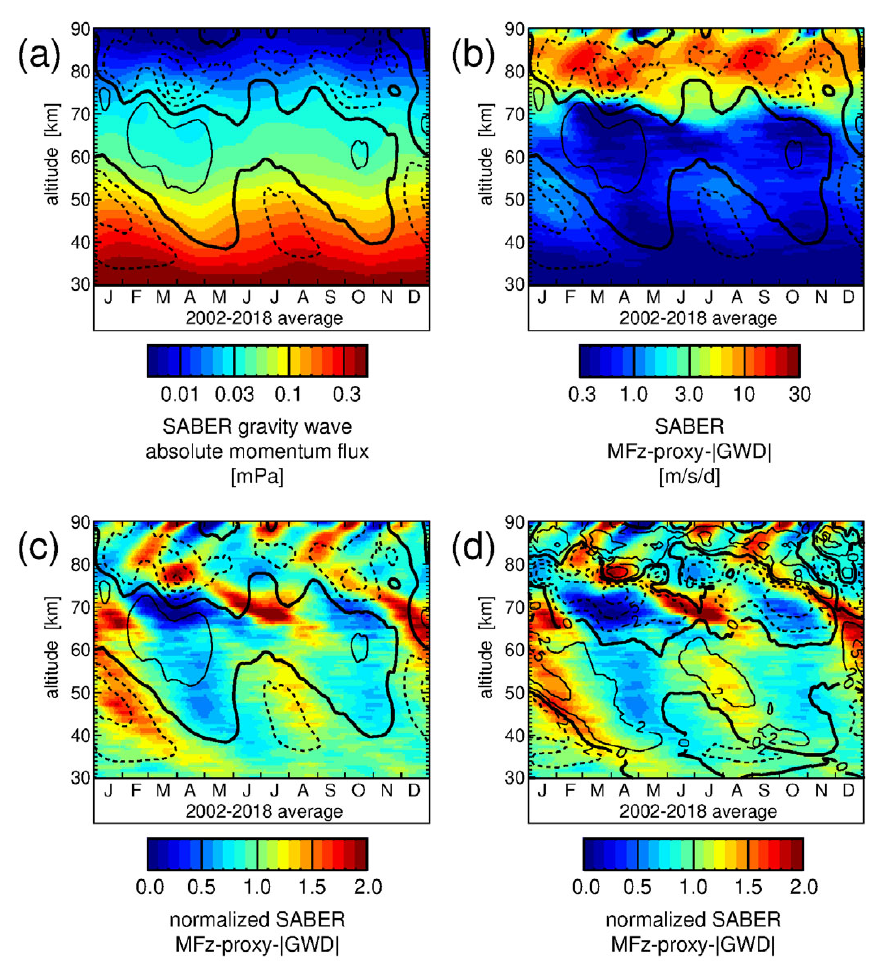
Figure 7. Typical seasonal variation of (a) SABER absolute gravity wave momentum fluxes, (b) SABER MFz-proxy- | GWD | , and (c) SABER MFz-proxy- | GWD | normalized by the altitude-dependent annual means. Overlaid in (a–c) are contour lines of the E/S/T-wind data set. Contour line increment is 20ms − 1 . The zero wind line is highlighted in bold solid contour lines, and westward (eastward) winds are indicated by dashed (solid) contour lines. In addition, (d) shows the same as (c) but overlaid contour lines are the vertical gradient d u/ d z of the E/S/T-winds. Contour lines are at 0, ± 2, ± 5, and ± 10ms − 1 km − 1 . Westward (meaning negative) gradients are indicated by dashed contour